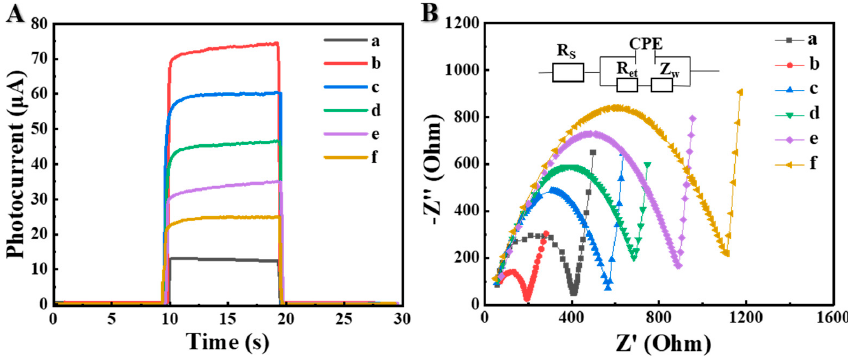
Figure 4. ( A ) PEC signals of the different modified photoelectrodes of μ PAD in PBS (0.1 M, pH 6.6) at 0.4 V: (a) paper-based ZnO, (b) ZnO/ZnIn 2 S 4 , (c) ZnO/ZnIn 2 S 4 /CS, (d) ZnO/ZnIn 2 S 4 /CS/Ab, (e) ZnO/ZnIn 2 S 4 /CS/Ab/BSA, and (f) ZnO/ZnIn 2 S 4 /CS/Ab/BSA/AFP ( c AFP = 0.1 ng mL − 1 ). ( B ) EIS for different modification procedure in PBS (0.1 M, pH 6.6) including [Fe (CN) 6 ] 3-/4- (6.0 mM) and KCl (0.2 M): (a) paper-based ZnO, (b) ZnO/ZnIn 2 S 4 , (c) ZnO/ZnIn 2 S 4 /CS, (d) ZnO/ZnIn 2 S 4 /CS/Ab, (e) ZnO/ZnIn 2 S 4 /CS/Ab/BSA, and (f) paper-based ZnO/ZnIn 2 S 4 /CS/Ab/BSA/AFP ( c AFP = 0.1 ng mL − 1 ).